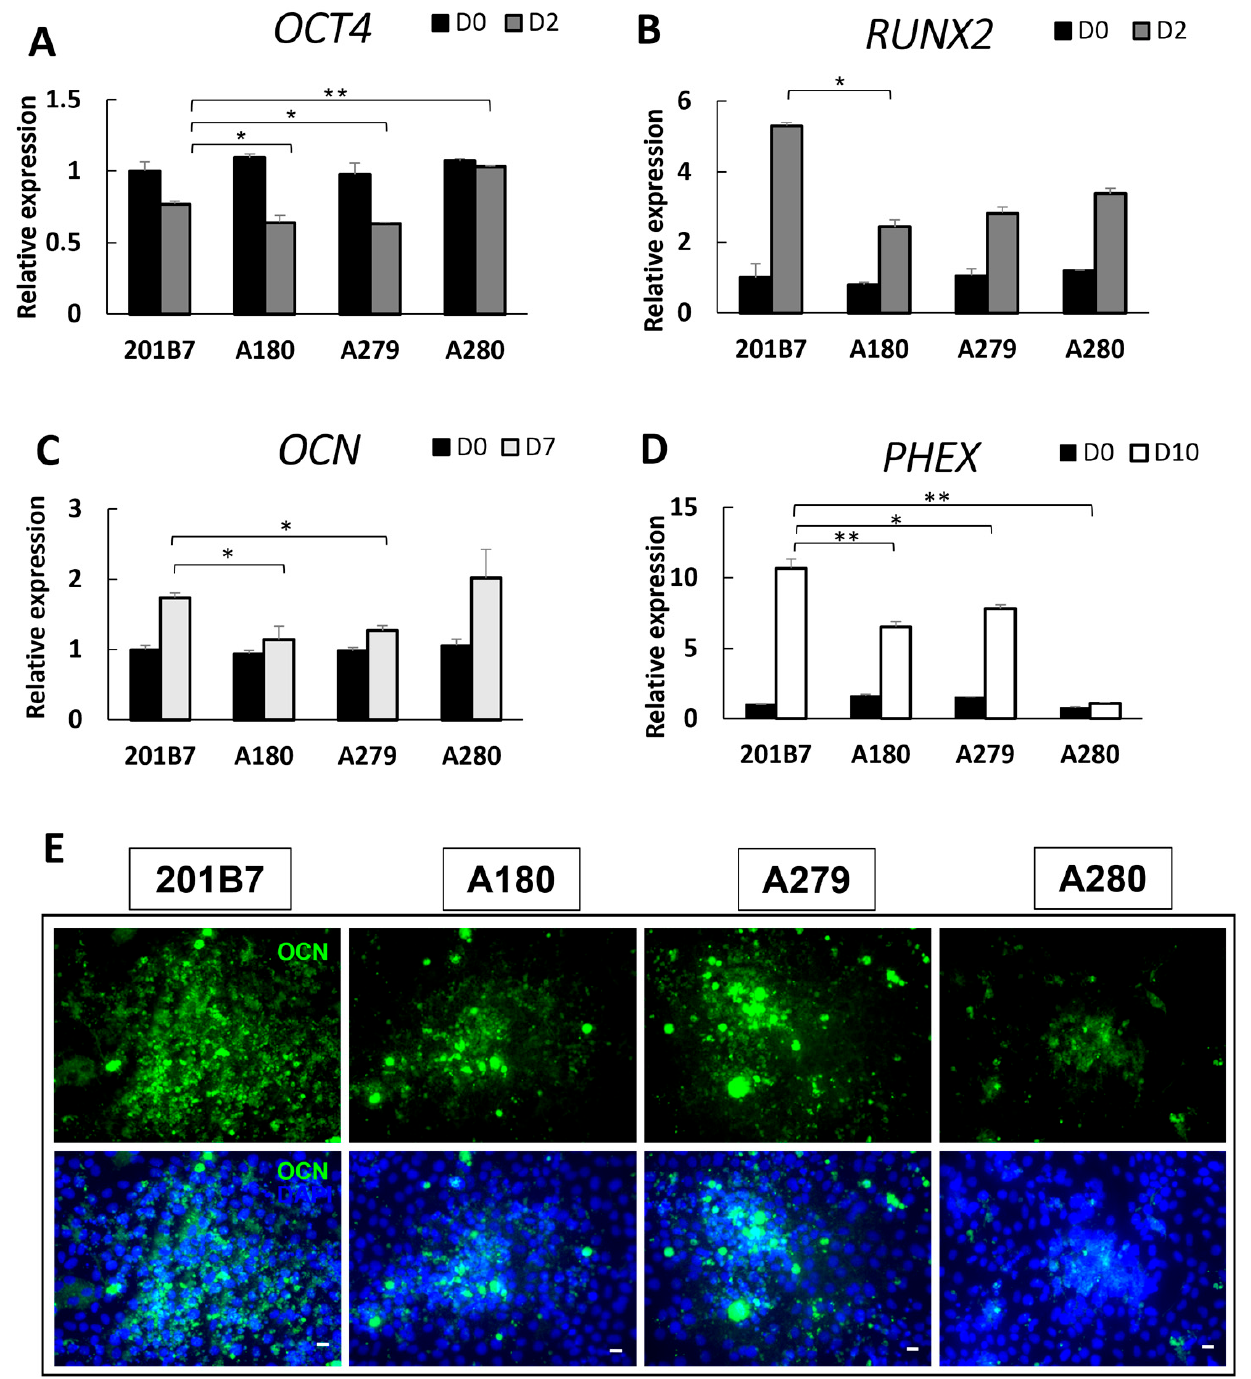
Figure 2. Differentiation of iPSCs into osteogenic lineages. ( A – D ) Quantification of the expression of undifferentiated pluripotent stem cell marker OCT4 and osteogenic differentiation stage-related genes RUNX2 , OCN , and PHEX on the indicated day expressed as a value relative to that of WT iPSCs on Day 0. ( E ) Immunostaining of osteoblast-specific protein OCN (green) on Day 7. The presence of the cells was confirmed by staining of nuclei with DAPI (blue). Scale bars, 20 µ m. Data expressed as the mean ± SD ( n = 3); * p < 0.05, ** p < 0.01.